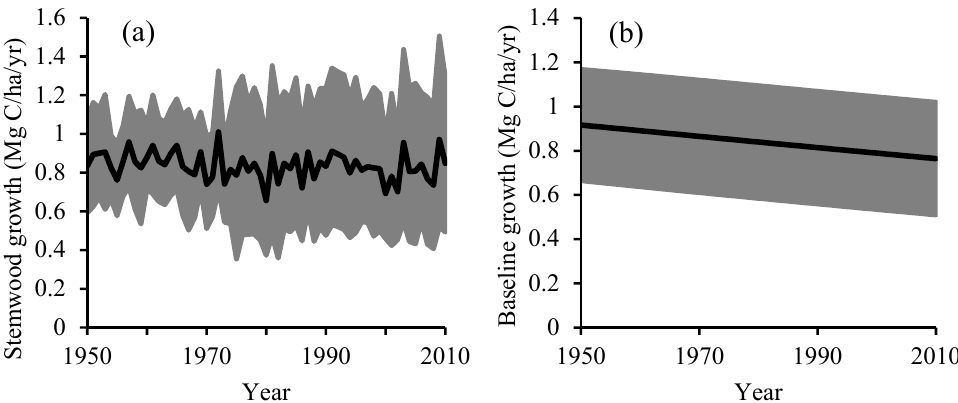
Figure 7. Temporal changes in stemwood growth (G_SW) ( a ) and baseline stemwood growth (B_SW) ( b )